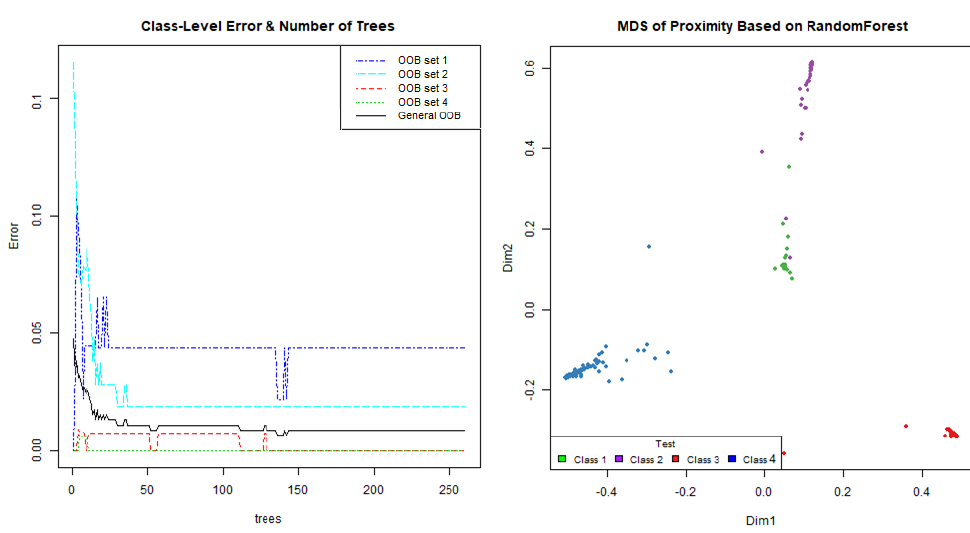
Figure 10. Random forest OOB analysis and final class